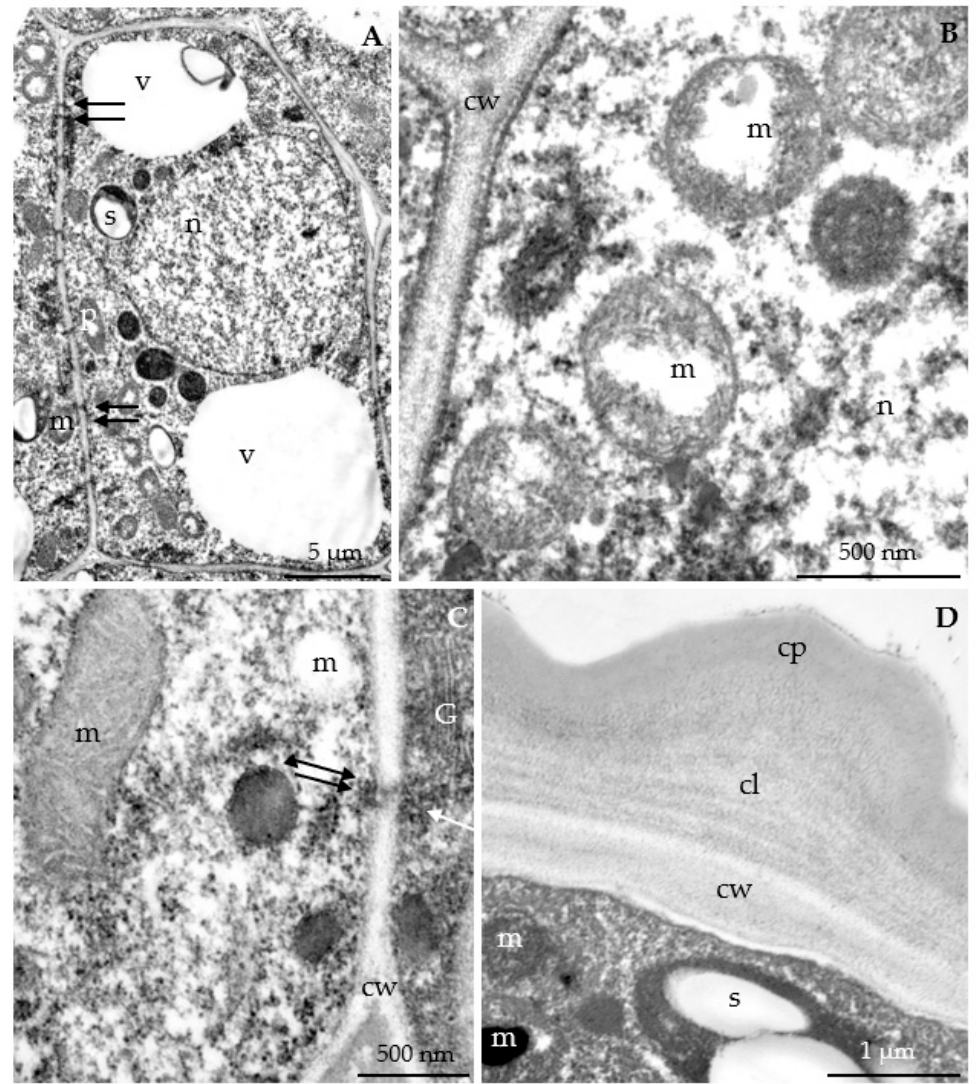
Figure 18. ( A – D ). Fragments of nectary epidermis ( B , D ) and parenchyma ( A , C ) cells in R. idaeus ‘Pokusa’ in the full secretion phase. ( A ): spherical cell nucleus (n), two vacuoles (v) occupying a large part of the protoplast, numerous plastids (p), sparse amyloplasts with starch grains (s), mitochondria (m), plasmodesmata (two arrows). ( B ): serially arranged mitochondria (m) near the cell wall (cw) and nucleus (n). ( C ): elongated and spherical mitochondria (m), Golgi apparatus (G) near the cell wall (cw), plasmodesma (two arrows), transport vesicles (arrow). ( D ): cell wall (cw) with a visible cuticle proper (cp) and cuticle layer (cl), plastid with a starch grain (s), mitochondria (m). The inner periclinal walls were tightly adjacent to the nectary parenchyma